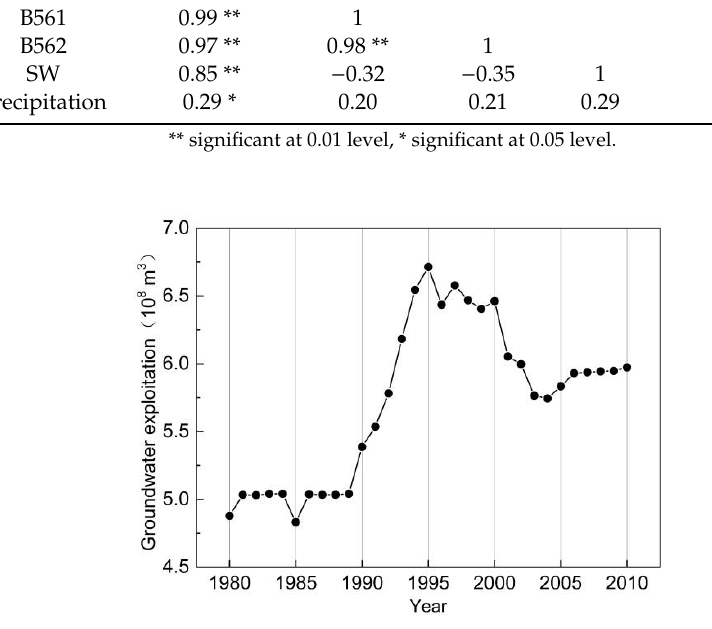
Figure 4. Groundwater exploitation from 1980 to 2010.